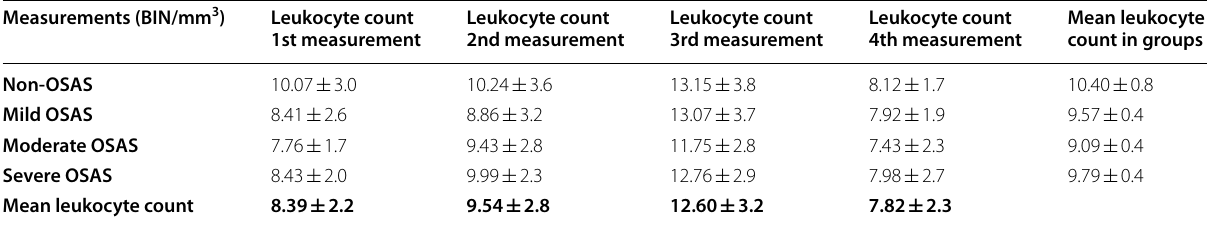
OSAS obstructive sleep apnea syndrome. Group 1: AHI: < 5, group 2: AHI: 5–15, group 3: AHI: 15–30, group 4: AH >: 30